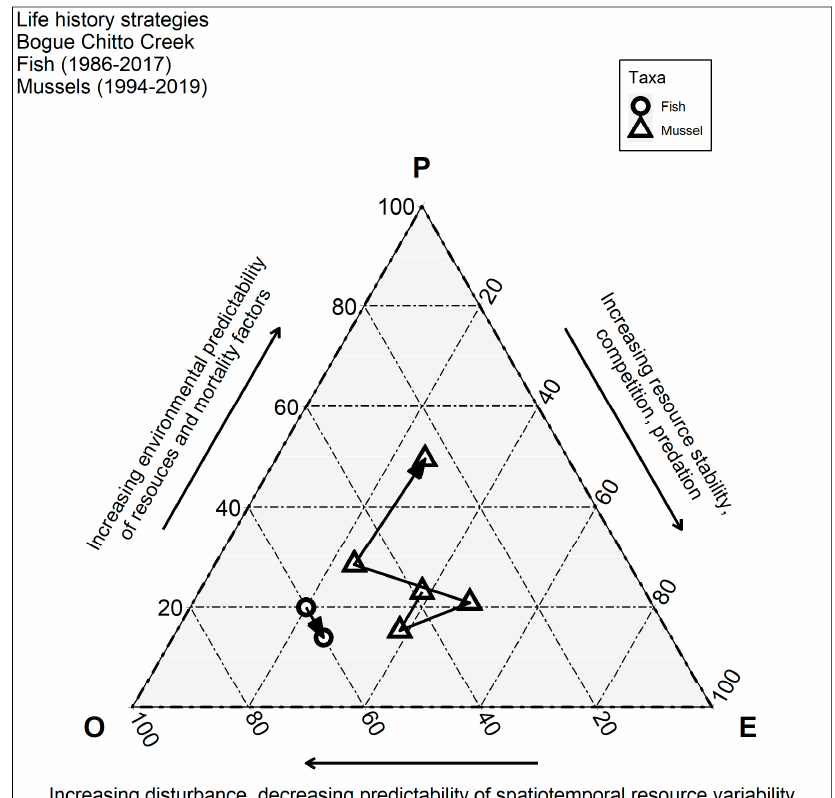
Figure 3 . Exploratory visualization of temporal variation in the proportion of species within the three life history strategies (E = equilibrium, O = opportunistic, and P = periodic) of fish and mussels in Bogue Chitto Creek.